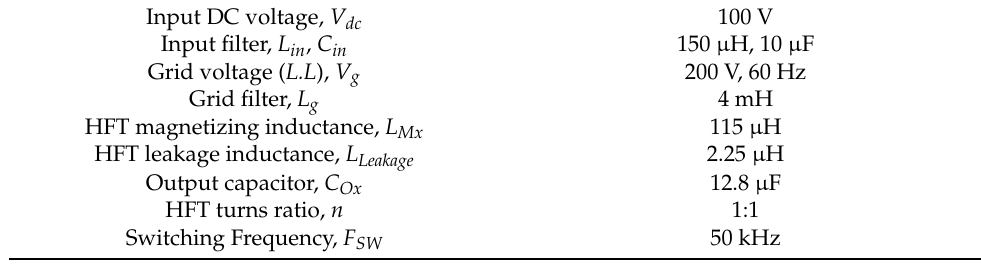
Table 3. Flyback converter parameters.